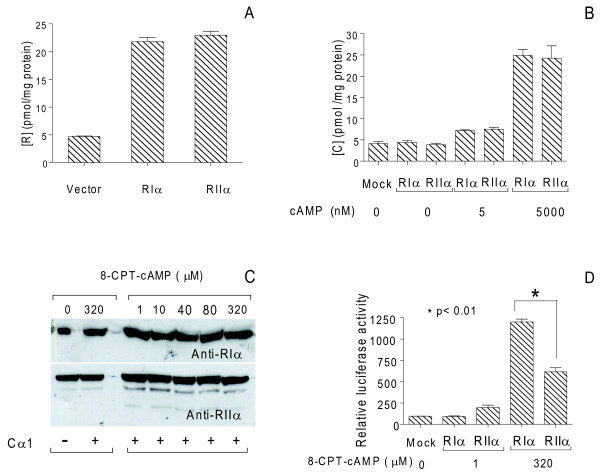
PKAII is less efficient compared to PKAI in regulating CRE activity in vivo. 293T cells were co-transfected with or without (empty vector, M), pDeCα1 (300 ng) together with either pExRIIα (320 ng) or pDeRIα (640 ng) for 24 h (A- C). (A) R subunit-specific activity (pmol cAMP/mg protein) was monitored in the presence of 25 μM [3H]-cAMP and showed comparable levels of RIα and RIIα. (B) Catalytic activity of Cα1 was monitored in the absence (0) and presence of low (5 nM) and high (5000 nM) concentrations of cAMP. In the presence of 5000 nM cAMP levels of transfected Cα1 released from RIα and RIIα were equal. (C) The stability of RIα and RIIα was monitored in the presence (+) and absence (-) of Cα1 and the absence (0) and presence of incremental doses (1-320 μM) of 8-CPT-cAMP. R subunit stability was determined according to immunoreactive R subunits after separation of cell extracts (25 μg total protein) on SDS-PAGE (12.5 % gels) and anti-RIα (1 : 300 dilution, upper panel) and anti-RIIα (1 : 400 dilution, lower panel). (D) 293T cells were left untreated (0) or stimulated for 1 hour with 8-CPT-cAMP (320 μM) before harvesting. Cell extracts were adjusted to 1 mg total protein/mL and assayed for PKA-specific phosphorylation of CREB monitored as relative luciferase activity at 560 nm. Data points represent relative luciferase activity +/- SD (n = 2-6).